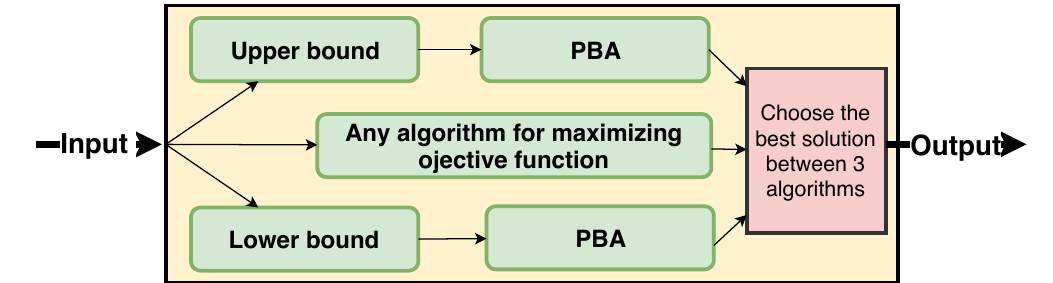
Figure 3. Framework of SPBA